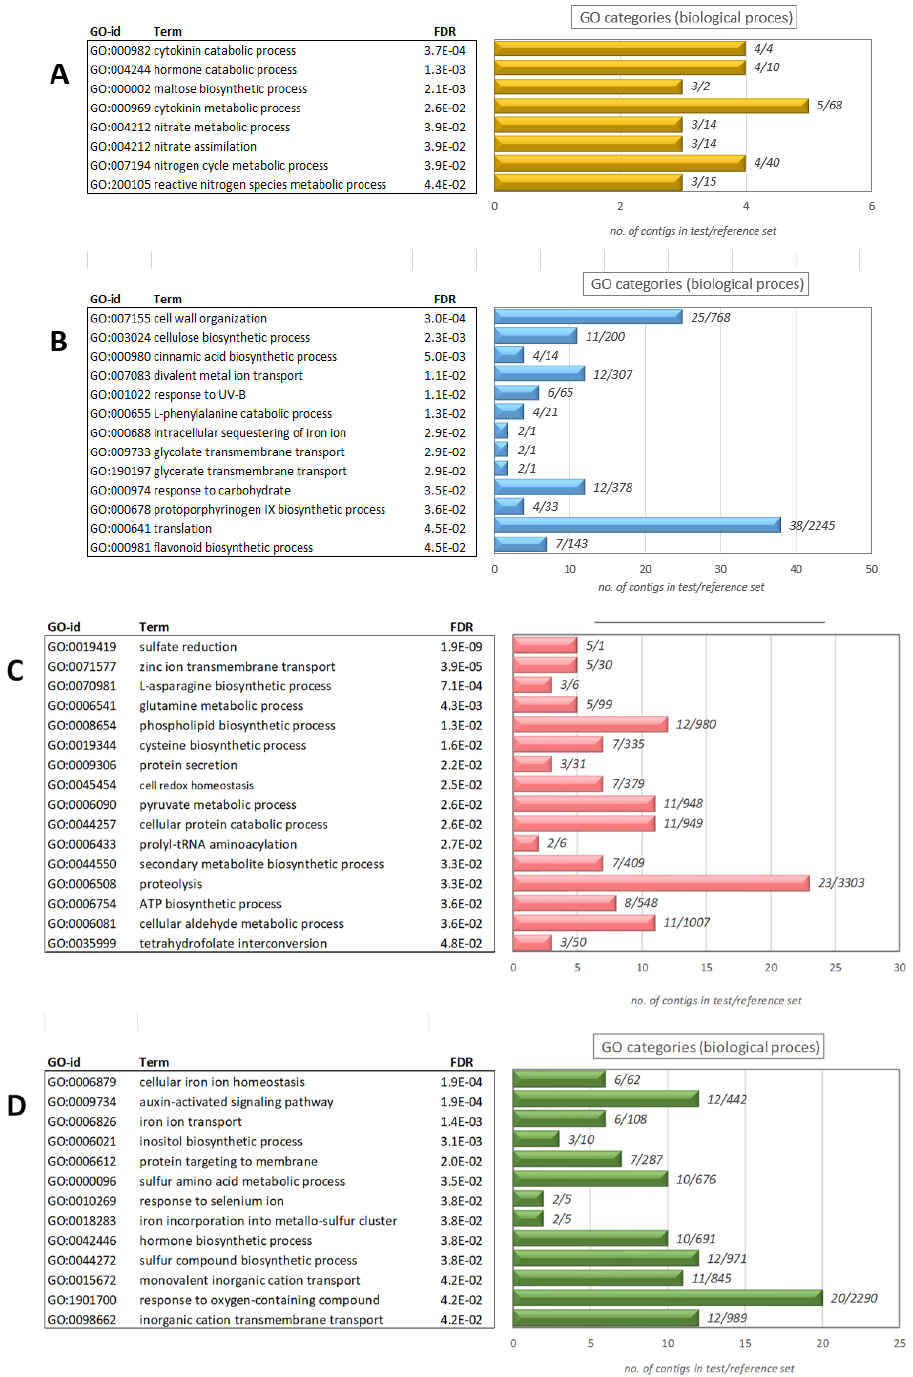
Figure 4. Gene ontology (GO) term enrichment analysis of the di ff erentially expressed contigs from prototype52097-treatedplants (24hafterapplication; false discovery rate(FDR) < 0.05). ( A )Upregulated GO terms in corn. ( B ) Down-regulated GO terms in corn. ( C ) Upregulated GO terms in soybean. ( D ) Down-regulated GO terms in soybean. The absolute number of contigs in the test set is represented by the bars in the graphs on the right (numbers of contigs in the test / reference sets are reproduced next to each